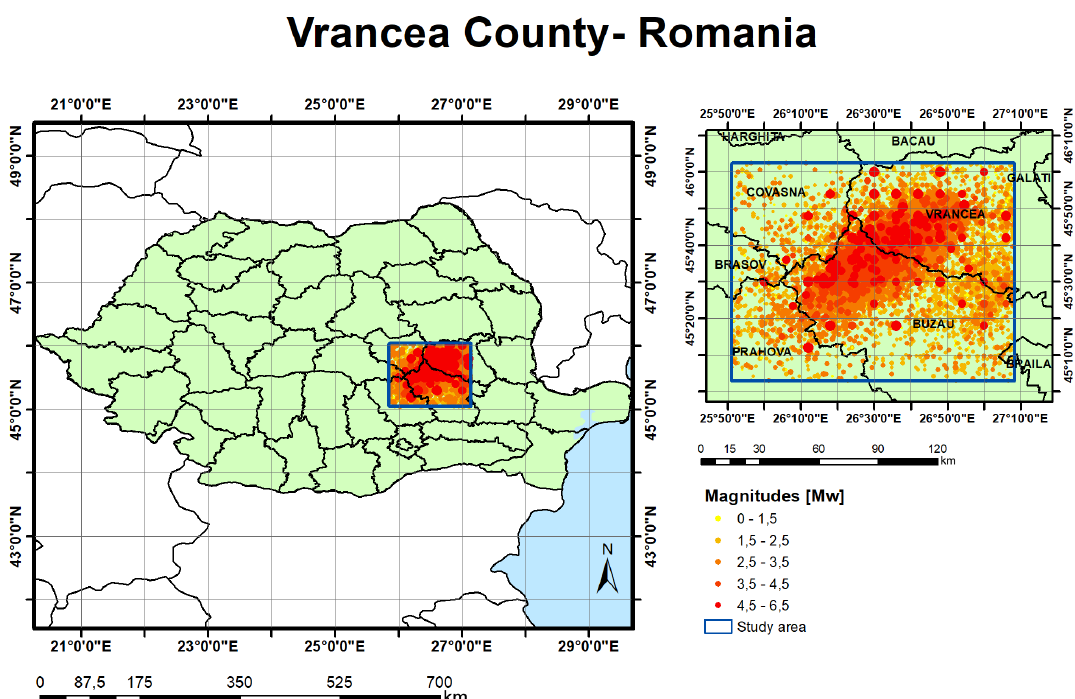
Figure 11. Plot of the catalog from 2000 to 2018 in the Vrancea region (Romania). Romanian province shape file obtained from WorldBank: Counties of Romania (National Agency of Cadastre and Land Registration).